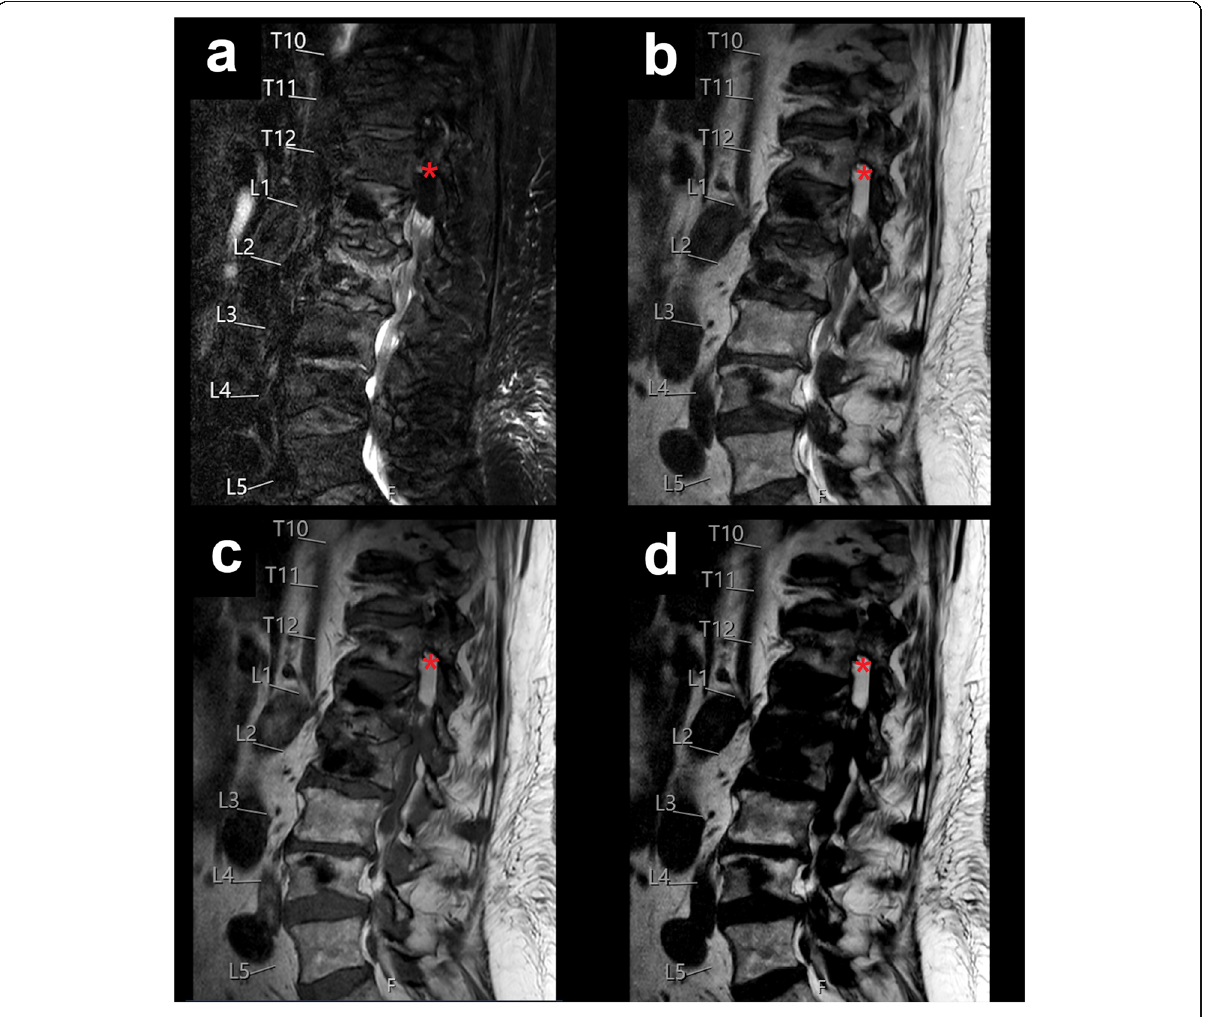
Fig. 2 Postoperative lumbar haematoma. This figure shows the lumbar spine of an 80-year-old female patient using water-only images ( a ), in- phase images ( b ), and fat-only images ( d ) of the sagittal T2-weighted DIXON sequence, together with a sagittal T1-weighted sequence ( c ). The patient had undergone decompressive lumbar hemilaminectomy and presented with a small lateralised postoperative haematoma of the intradural extramedullary space between T12 and L1 (red